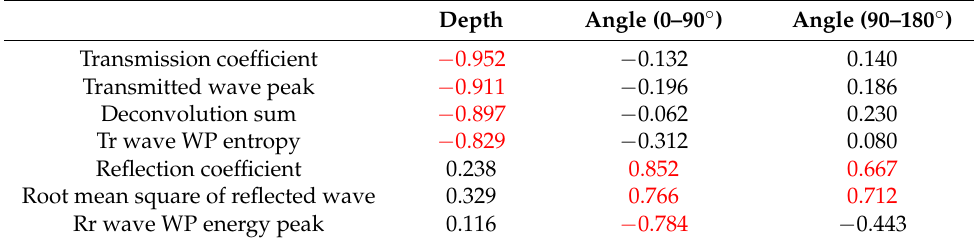
Table 2. Selected correlation coefficients.